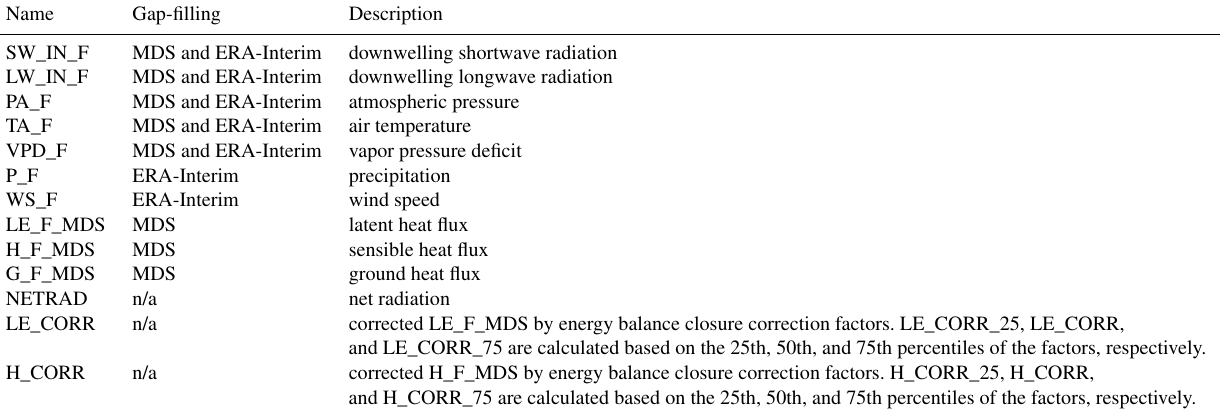
Table 1. Information about the variables used from FLUXNET2015. The marginal distribution sampling (MDS) filling method is based on Reichstein et al. (2005), and the ERA-Interim filling method can be found in Vuichard and Papale